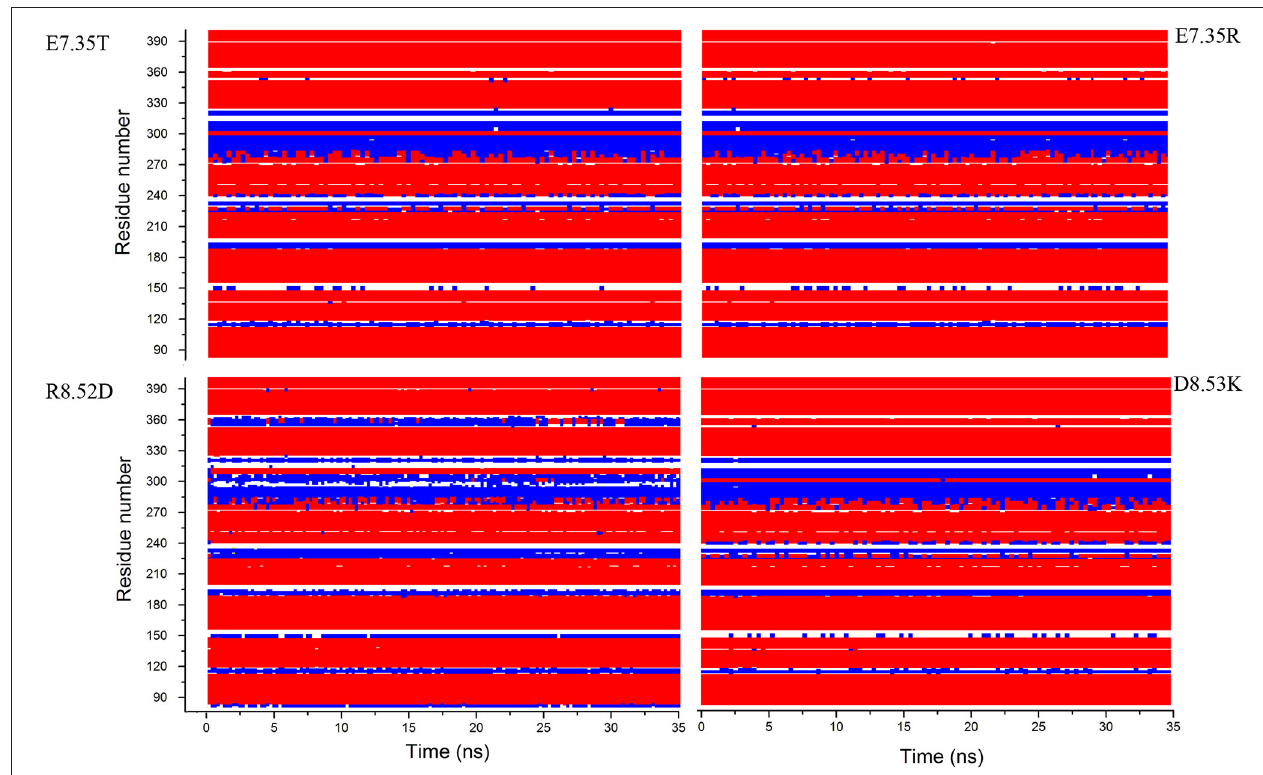
FIGURE 2 | Secondary structure for the mutants E7.35T, E7.35R, R8.52D and D8.53K calculated over the molecular dynamic (MD) trajectory . Red represents helix conformation, blue represents turn conformation, white represents random coil